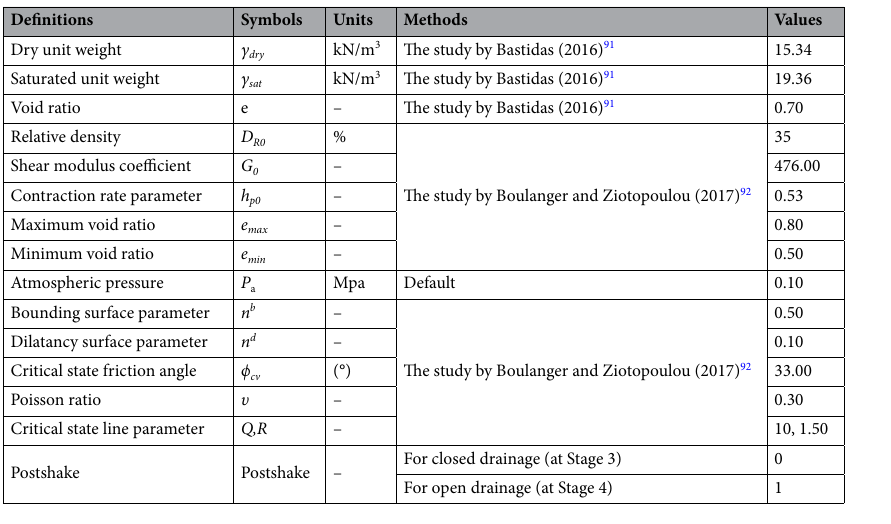
Table 6. PM4Sand parameters Ottawa sand with a relative density of